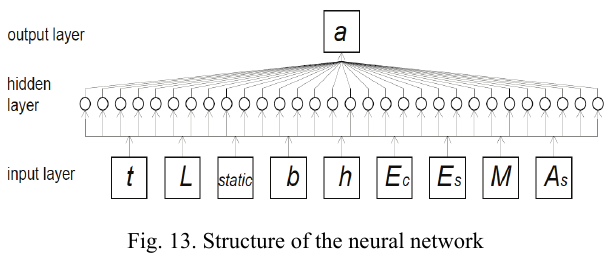
Fig. 13. Structure of the neural network that can be used in future